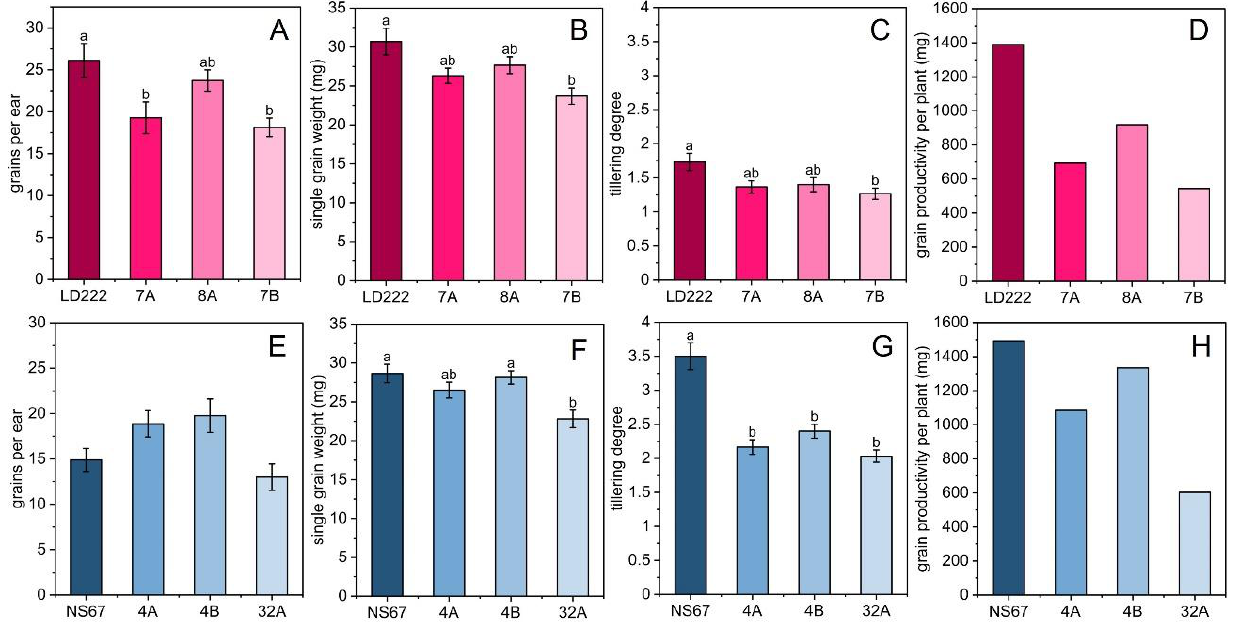
Figure 6. Productivity parameters measured at the end of the season in durum- and bread-wheat mature plants. ( A , E ) Average number of grains per ear (n ears = 10). ( B , F ) Average weight of a single grain harvested from the 10 ears used in the previous measurement. ( C , G ) Tillering degree is the average tillering degree in durum and bread wheat (n = 30). Histograms represent average values ± Standard Error; different letters indicate a significant difference at p < 0.05, as determined using one-factor ANOVA followed by Tukey’s test. ( D , H ) Grain productivity per plant, a synthetic parameter that combines the previous three and estimates the mass of grains that was produced by a single plant for each wheat line.